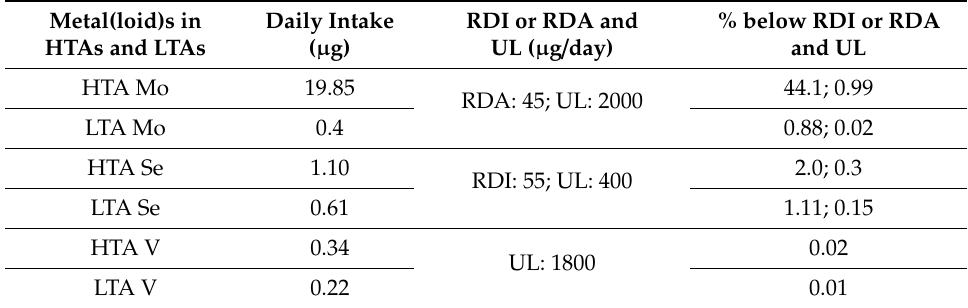
Table 6. Summary of the dietary exposure to metal(loid)s from tea consumption representative of 1.54 days per week in comparison to the RDI or RDA, and UL in HTA and